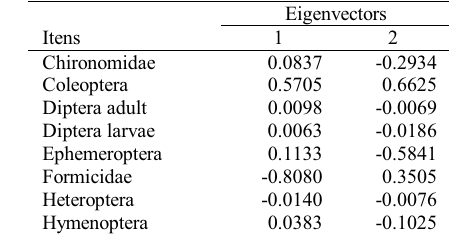
Table 2. PCA axis 1 and axis 2 eigenvectors for dietary data (eight main items) of individuals of Thoracocharax stellatus from the upper rio Tocantins.